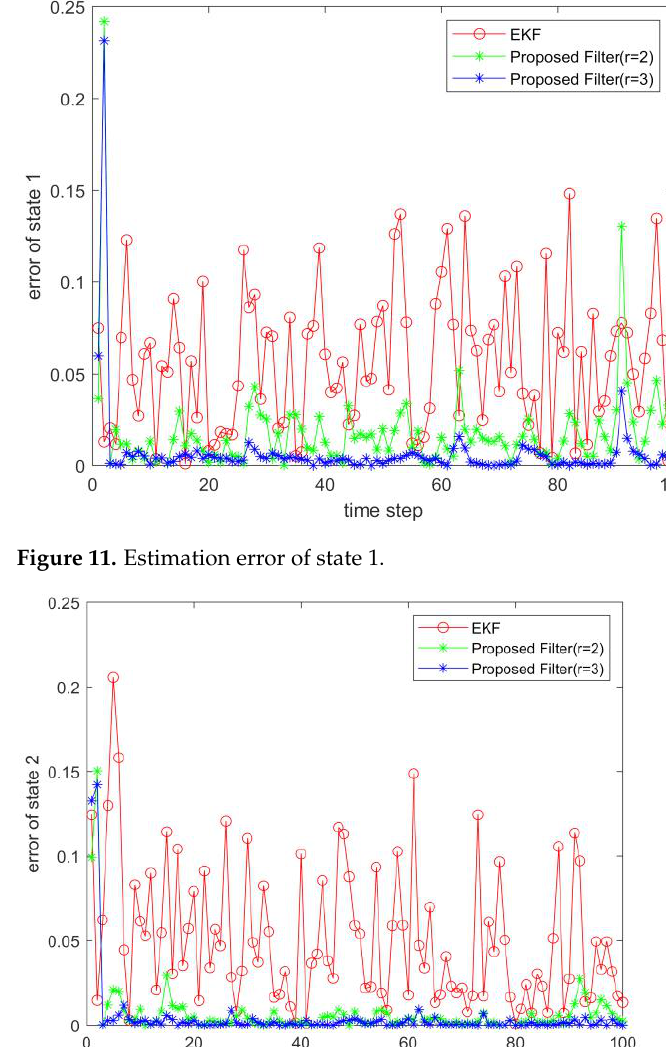
Figure 12. Estimation error of state 2.